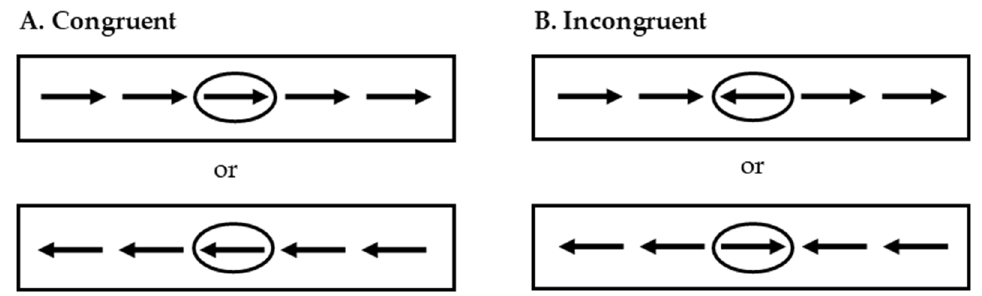
Figure 2. Flanker task. ( A ) Presented the two possibilities for a congruent trial. ( B ) Presented the two possibilities for an incongruent trial. possibilities for an incongruent